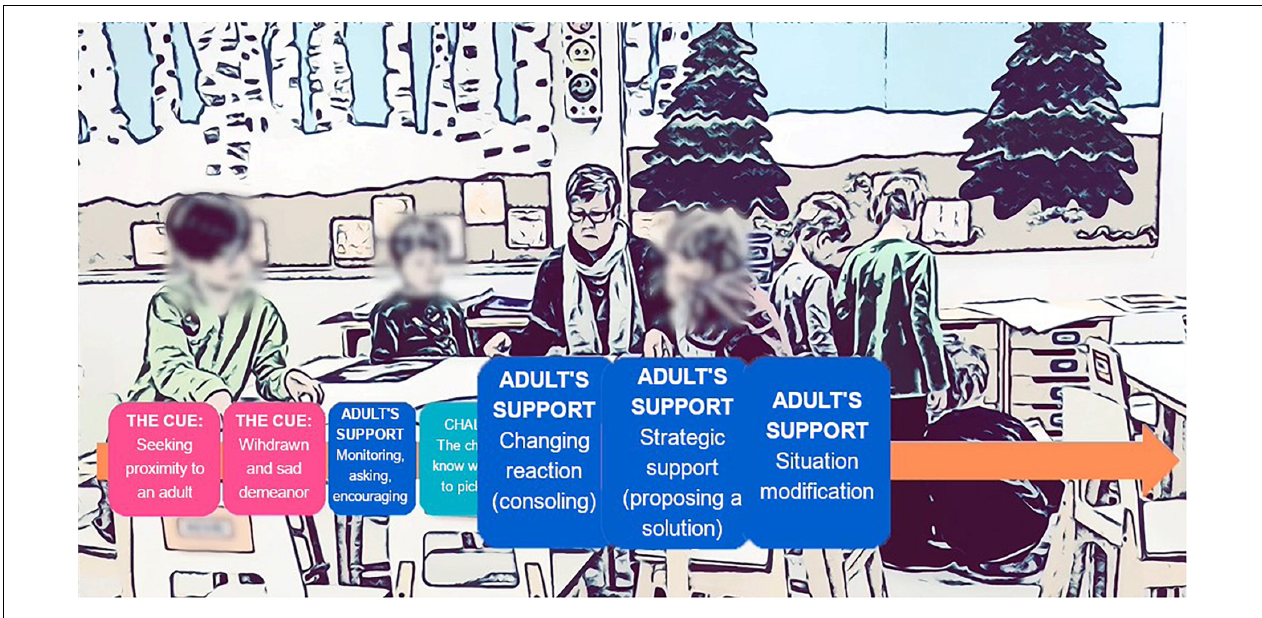
FIGURE 4 | A screenshot of a case video with